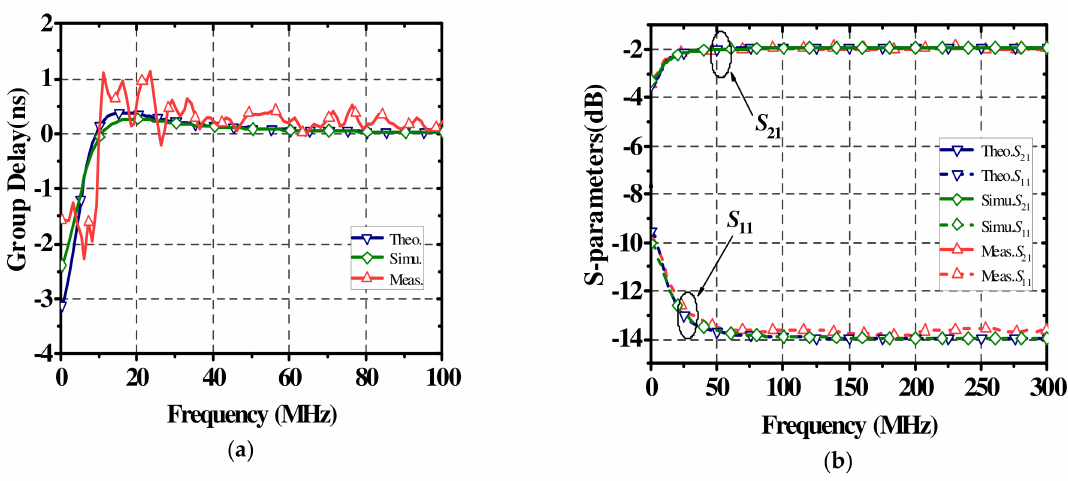
Figure 10. Theory, simulation and measurement of low-pass NGD circuits: ( a ) group delay; ( b ) S 21 and S 11 .